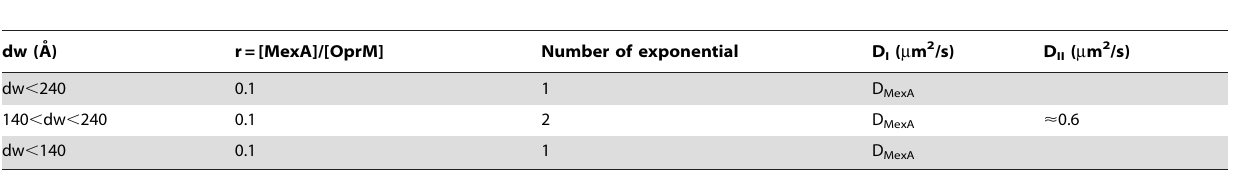
Table 1. The first column gives the values of the separation distance between bilayers and the second one the molar ratio of MexA over OprM protein.